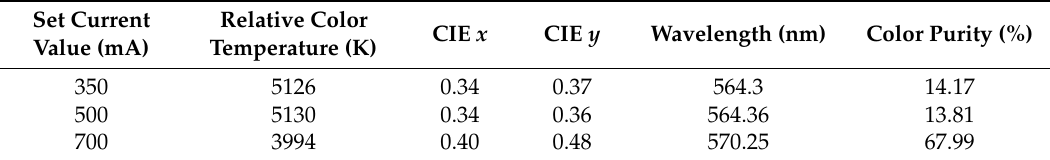
Table 1. Luminous efficacy of white QD-LED at 350, 500 and 700 mA. CIE stands for Commission International de l’éclairage.